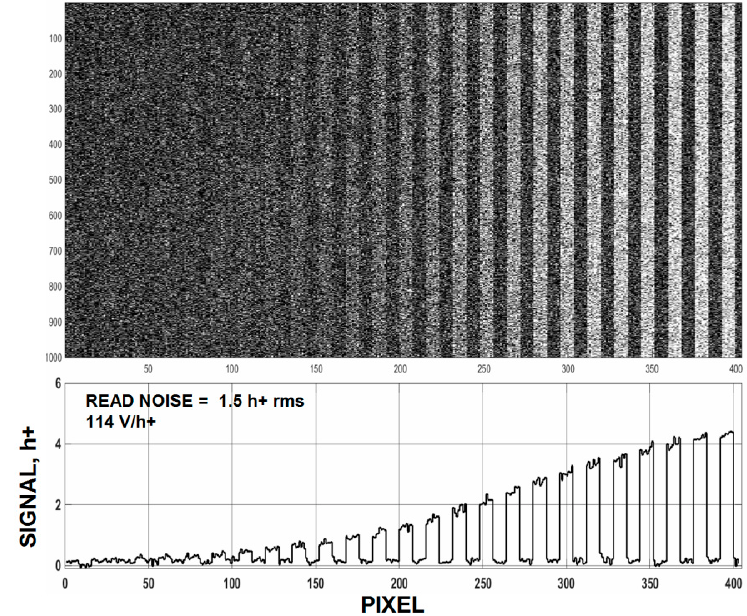
Figure 17. Low light image for a 10 um 5T pinned photo diode (PPD) PMOS pixel